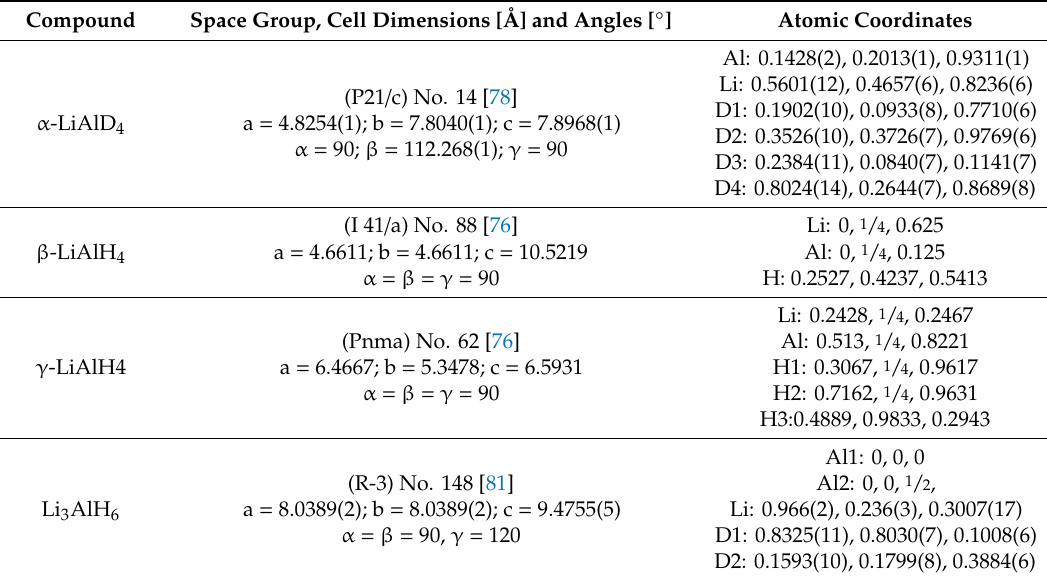
Table 2. Crystallographic data of